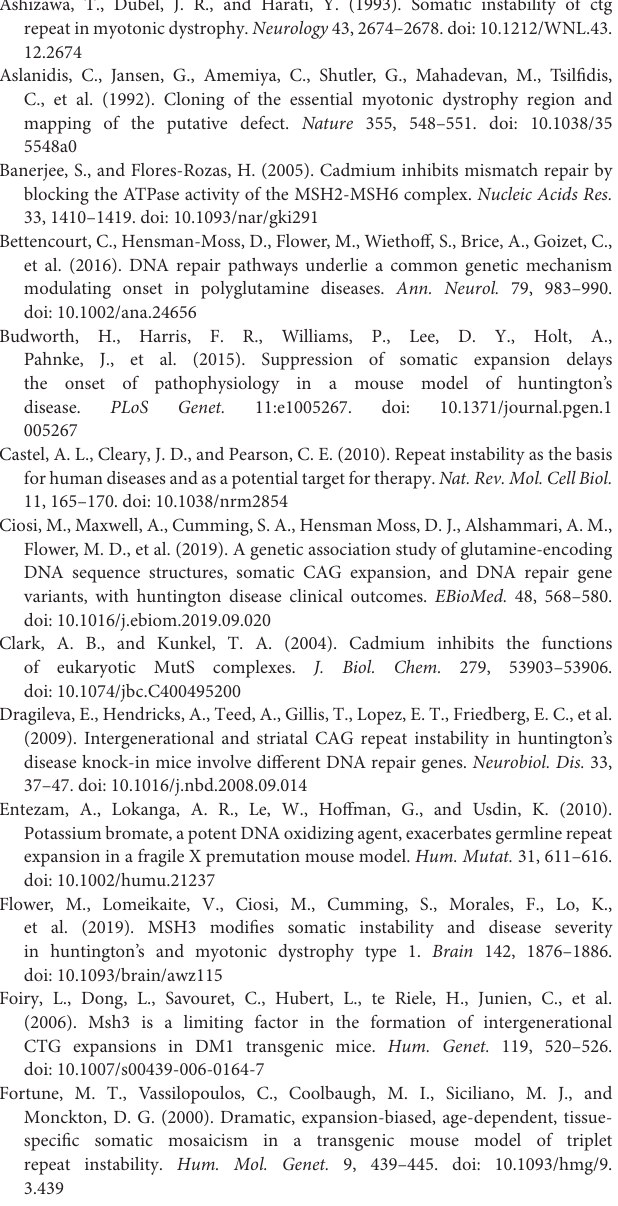
Supplementary Figure 2 | Cell survival in the presence of metal compounds. Semi-logarithmic representation of the mean cell survival ( ± SD) of D2763Kc2 duplicate cultures exposed to increasing concentrations of metal compounds, over a period of seven days. Concentrations were plotted using a logarithmic scale. Cell survival was assessed by a trypan blue exclusion assay. Supplementary Figure 3 | Cell survival in the presence of oxidants and antioxidants. Semi-logarithmic representation of the mean cell survival ( ± SD) of D2763Kc2 duplicate cultures exposed to increasing concentrations of hydrogen peroxide and multiple antioxidant compounds, over a period of seven days. Ethanol was used as control vehicle. Concentrations were plotted using a logarithmic scale. Cell survival was assessed by a trypan blue exclusion